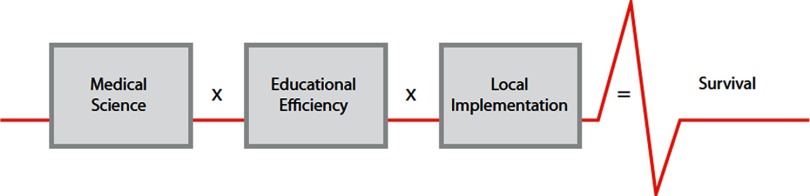
The Utstein Formula of SurvivalAdapted with permission from Søreide et al.27